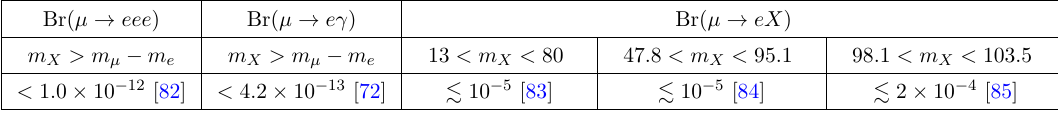
Table 2 . Upper bounds on the branching ratios of µ → eee , µ → eγ , and µ → eX . Masses are in MeV.